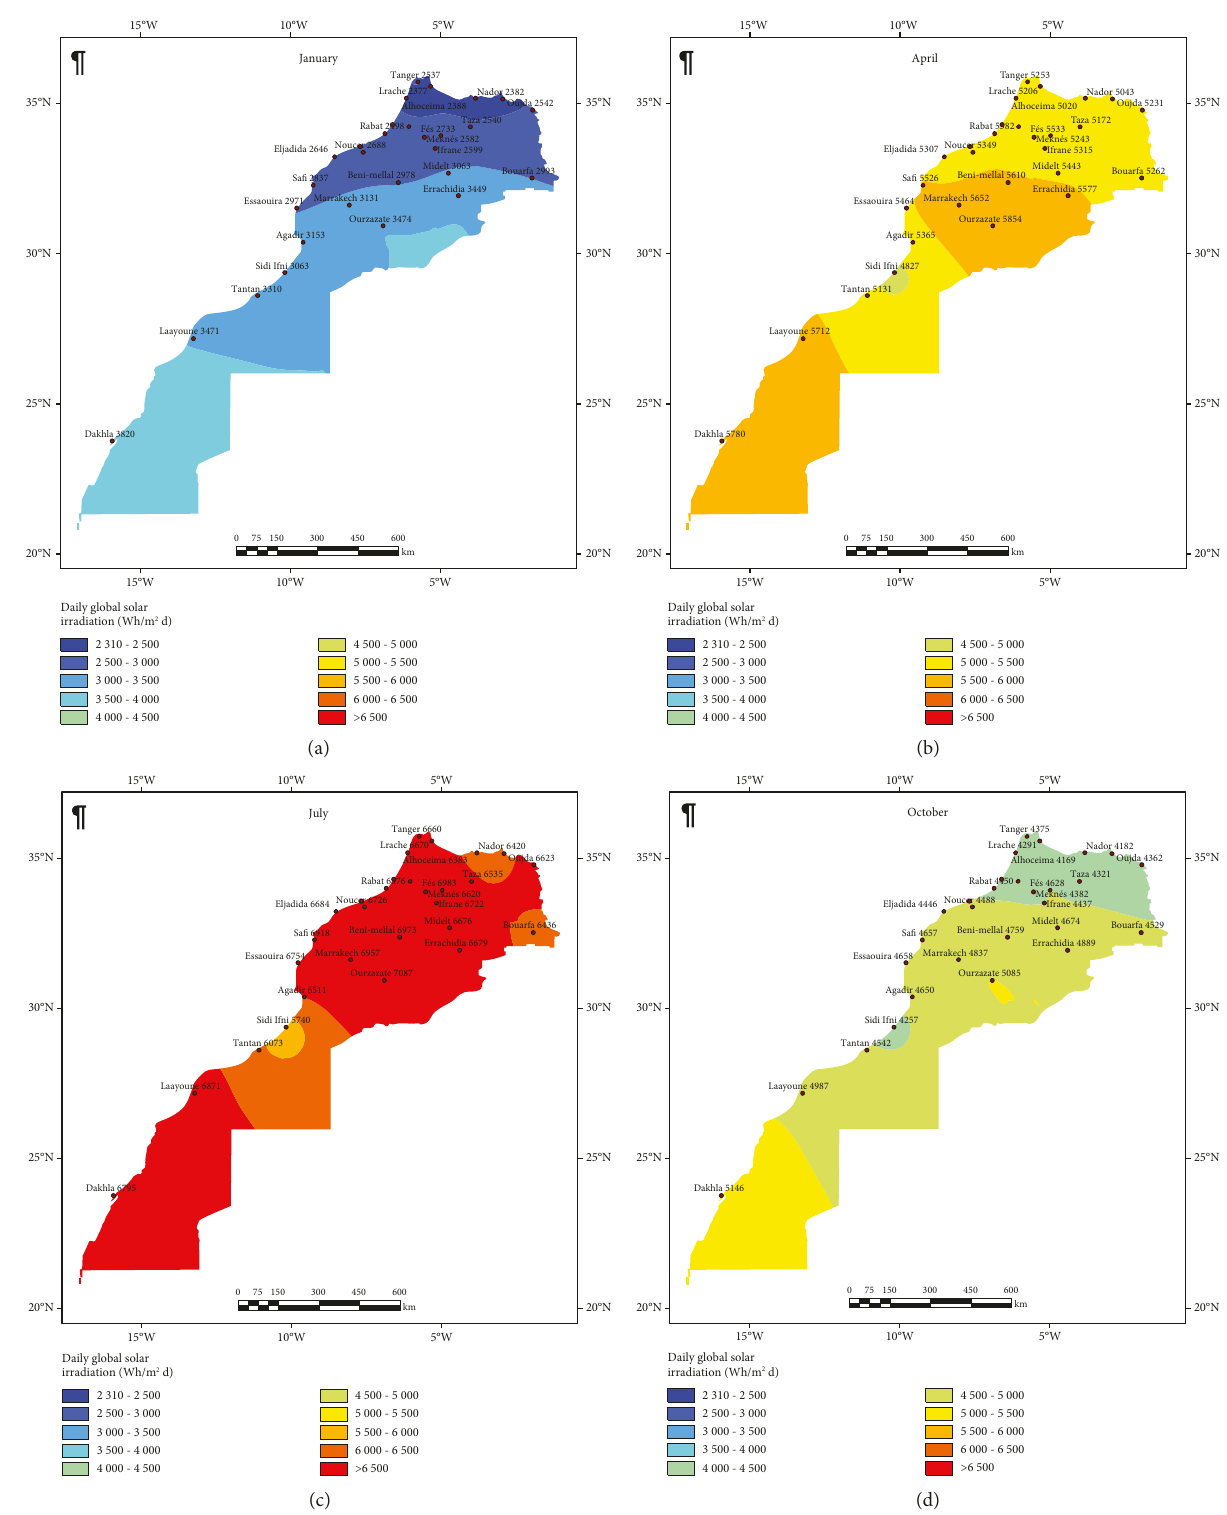
Figure 5: Maps of the monthly average values of daily global irradiations on a horizontal plane, coming from Morocco. Maps of global solar radiation on a horizontal plane (a –